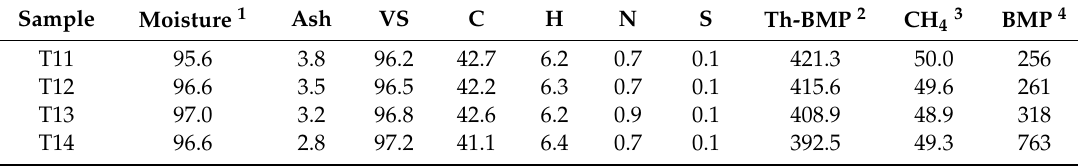
Table 2. Composition of solid residues from the samples of the WOP1 test. Unless specified